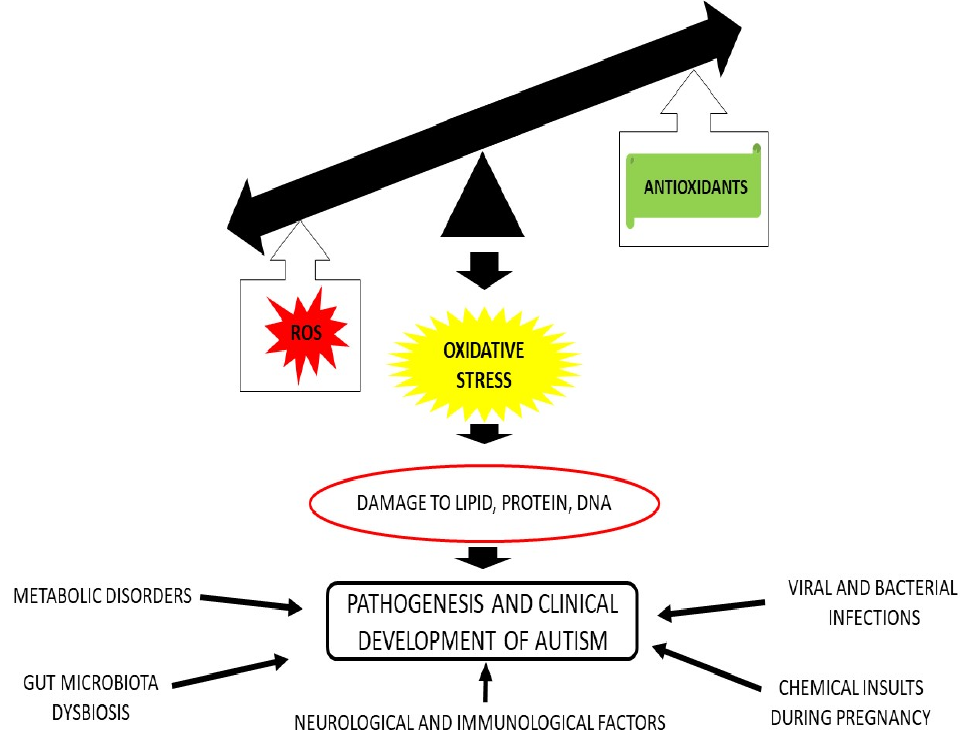
Figure 1. Relationship among the main determinants of ASD.